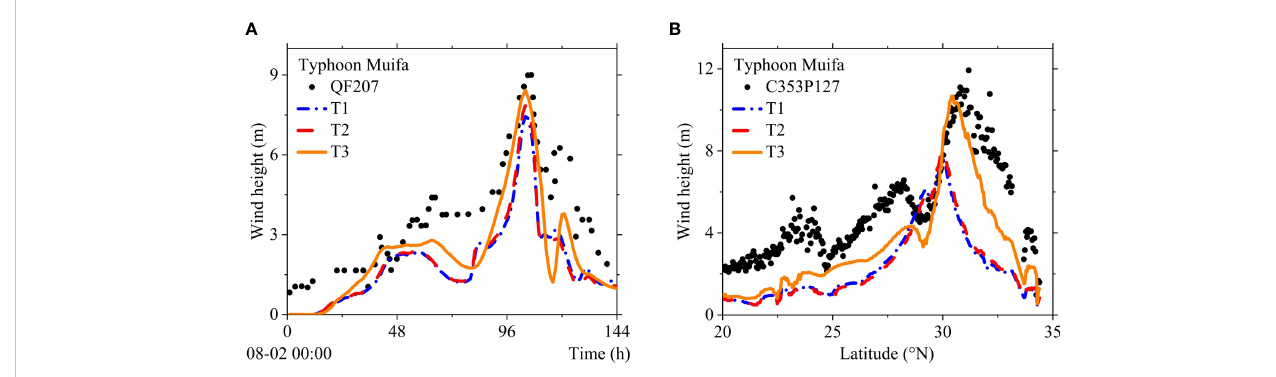
FIGURE 5 Typhoon waves: (A) the modeled and buoy station observed, (B) the modeled and satellite